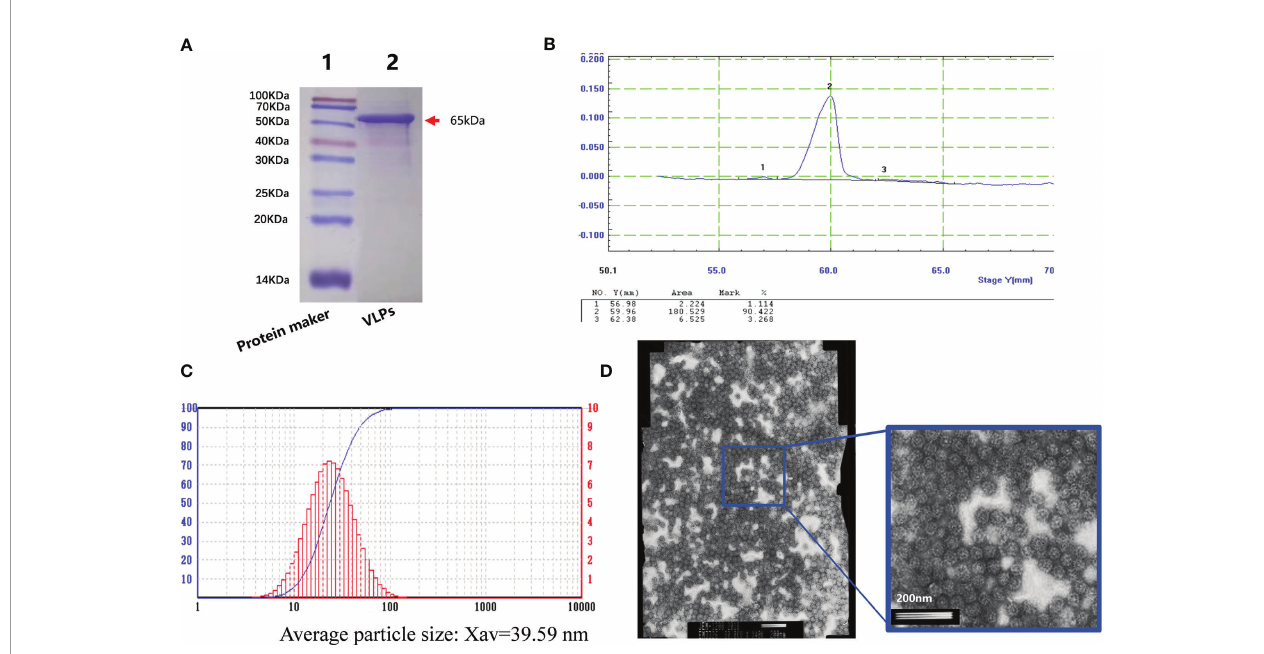
FIGURE 2 | Puri fi cation of virus-like particles (VLPs). SDS-PAGE analysis of puri fi ed VLPs obtained from SF9 cells infected with the recombinant baculovirus for 5 days. Puri fi cation was performed using the AKTA puri fi cation system. (A) . Densitometric scanning pro fi le of the SDS-PAGE results from (A) showing the puri fi cation ef fi ciency was greater than 90% (B) . Particle size analysis of the puri fi ed VLPs (C) . Electron micrograph of the puri fi ed VLPs (D)